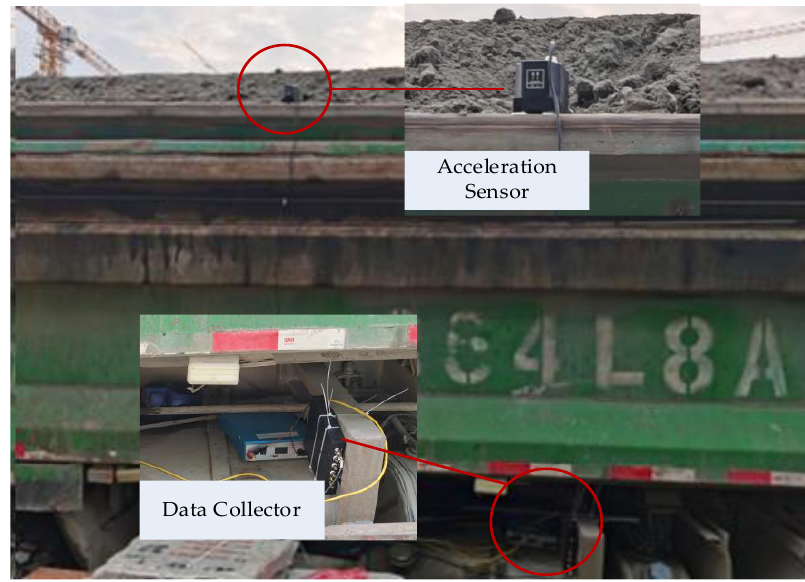
Figure 10. Vibration action of earthwork truck.